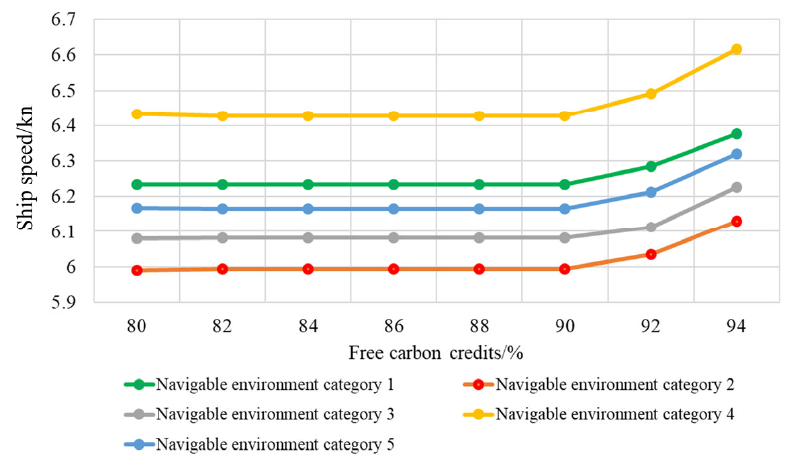
Figure 19. Optimal speeds in different navigation environments under different free carbon credits.